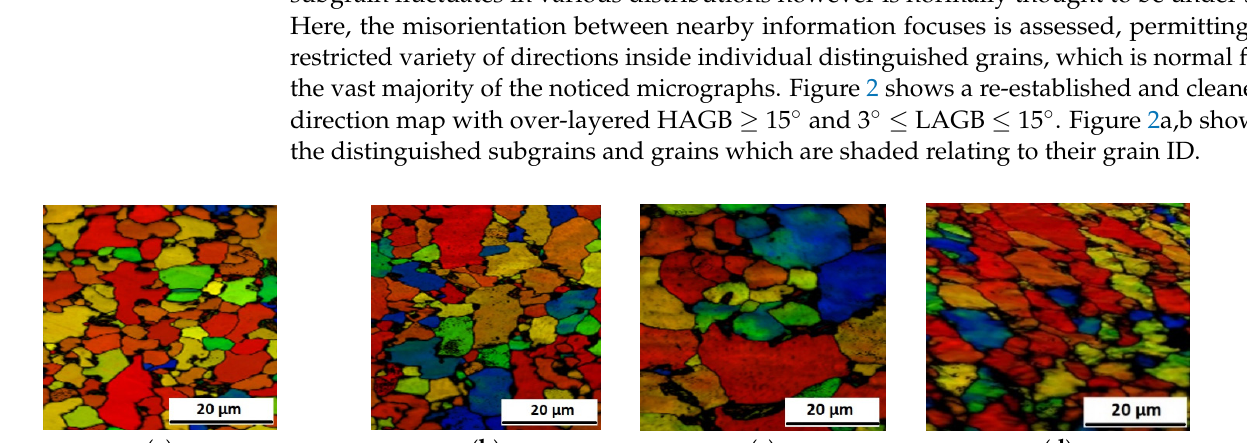
Figure 2. EBSD micrograph of Al5083 alloy after ECAP processing ( a ) no pass, ( b ) first pass, ( c ) second pass, ( d ) third pass at ambient temperature.